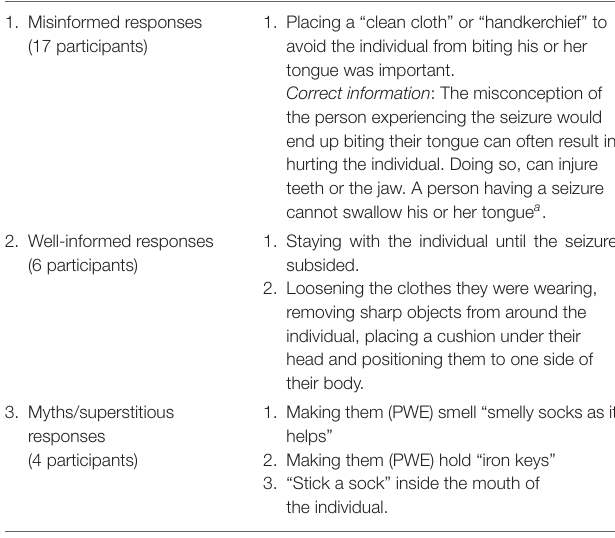
TABLE 2 | Open-ended responses of online participants sharing observations in the case of witnessing a seizure (number of participants in each category is indicated within